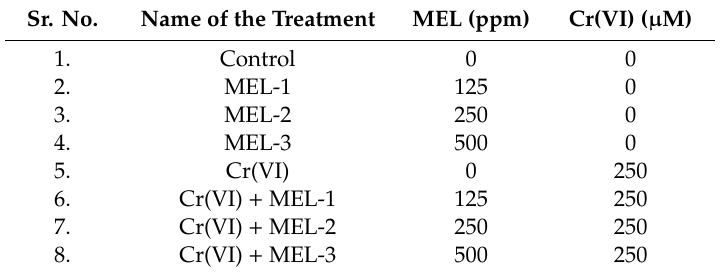
Table 1. Di ff erent treatments given to Vigna radiata in the present investigation. Sr.